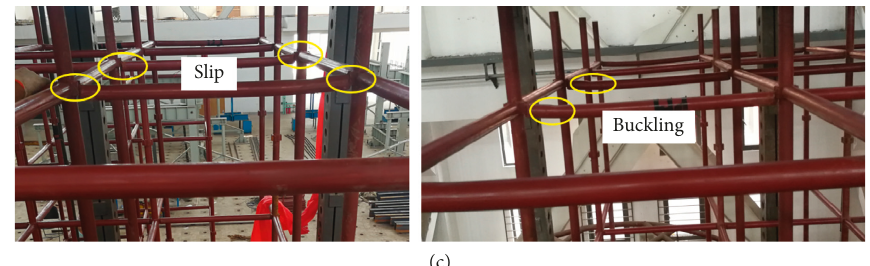
Figure 17: Failure situations of Model 4. (a) Overall buckling deformation of scaffold. (b) Failure of the top fastener. (c) Deformation of horizontal rods in the loading